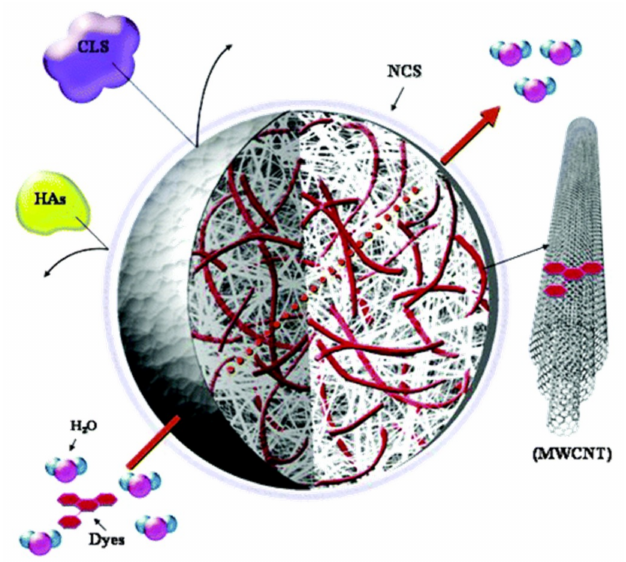
Figure 2. Schematic representation of the advantageous performances of the caged MWCNTs on dye adsorption. Reprinted with permission from [25]. Copyright (2008) American Chemical